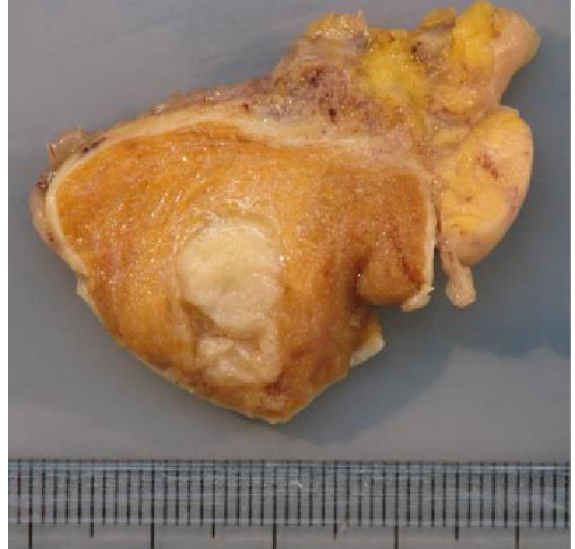
Figure 5. Macroscopic examination showing a firm whitish nodule corresponding to the BOTT (same patient as Figure 3).